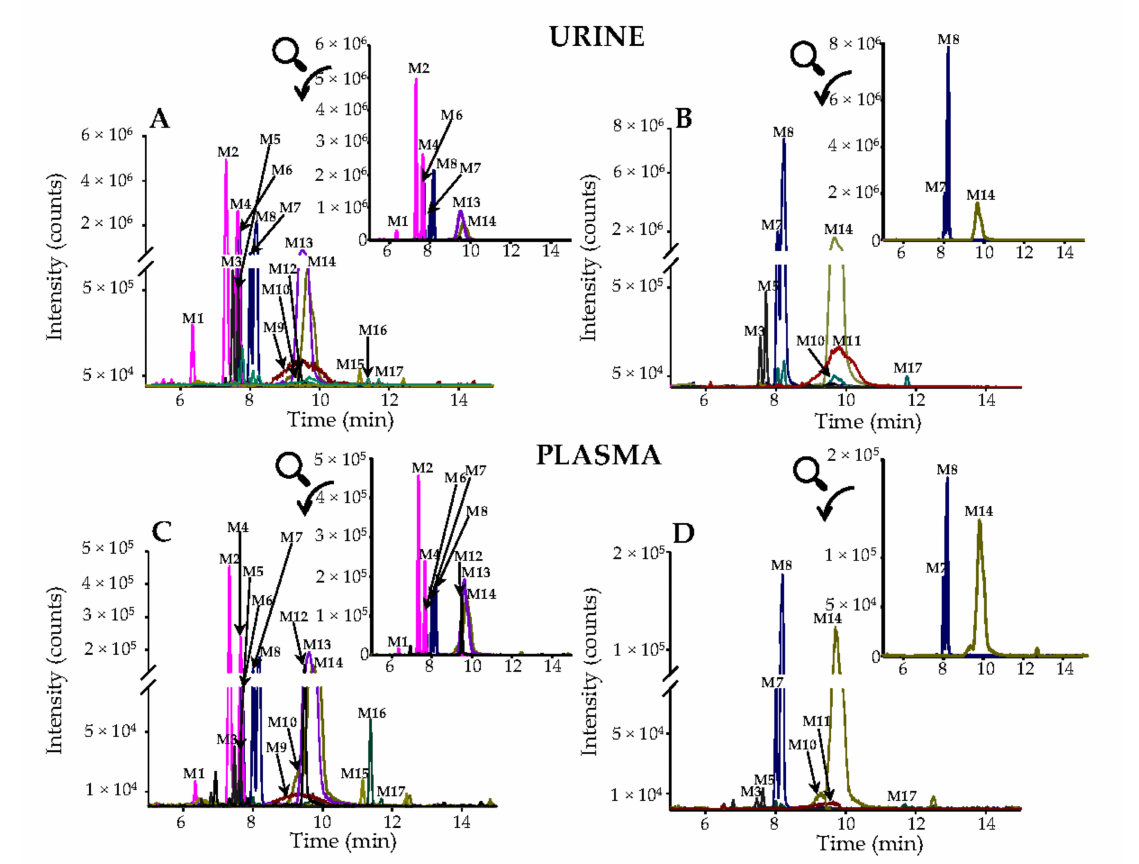
Figure 2. Representative extracted ion chromatograms (EICs) of urine and plasma metabolites after consuming ( A , C ) lemon or ( B , D ) orange extract. Numbers designate the metabolites according to Table